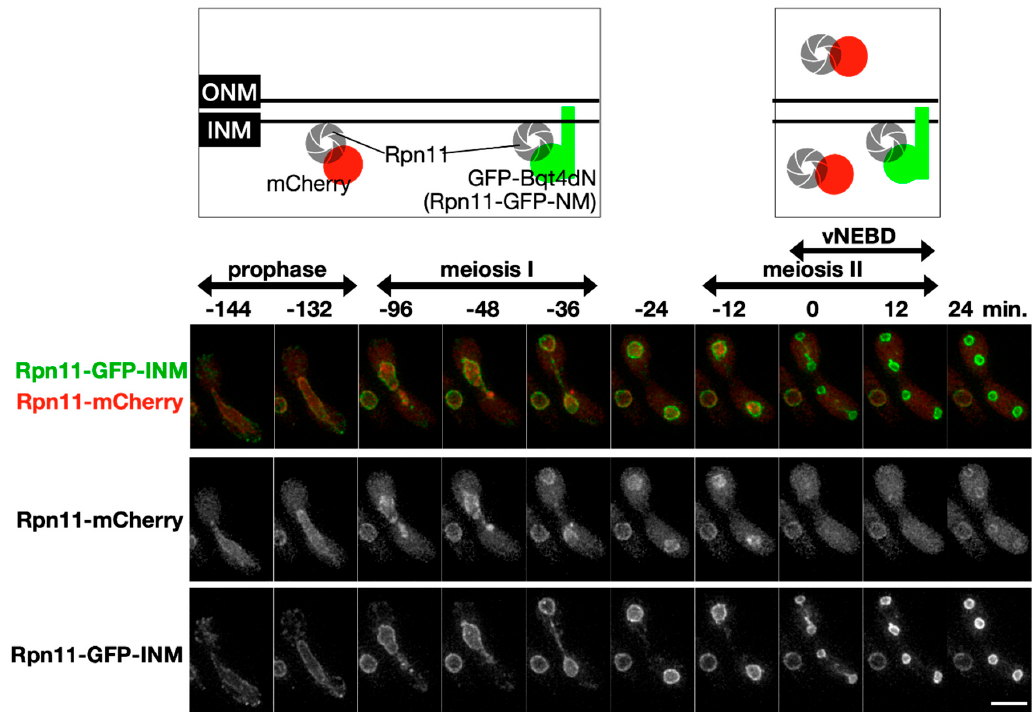
Figure 2. The fusion protein Rpn11-GFP-INM stays at the inner nuclear membrane during vNEBD. Upper panel: illustration of Rpn11-mCherry and Rpn11-GFP-INM localization at different meiotic cell cycle stage. Lower panel: representative time-lapse fluorescence images of Rpn11-mCherry and Rpn11-GFP-INM during meiosis. Scale bar: 5 µm.